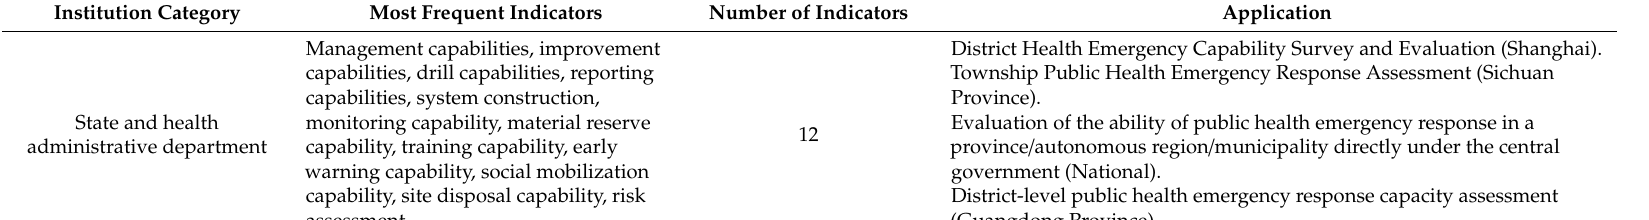
Table 4. Characteristics and application of indicators in evaluation system